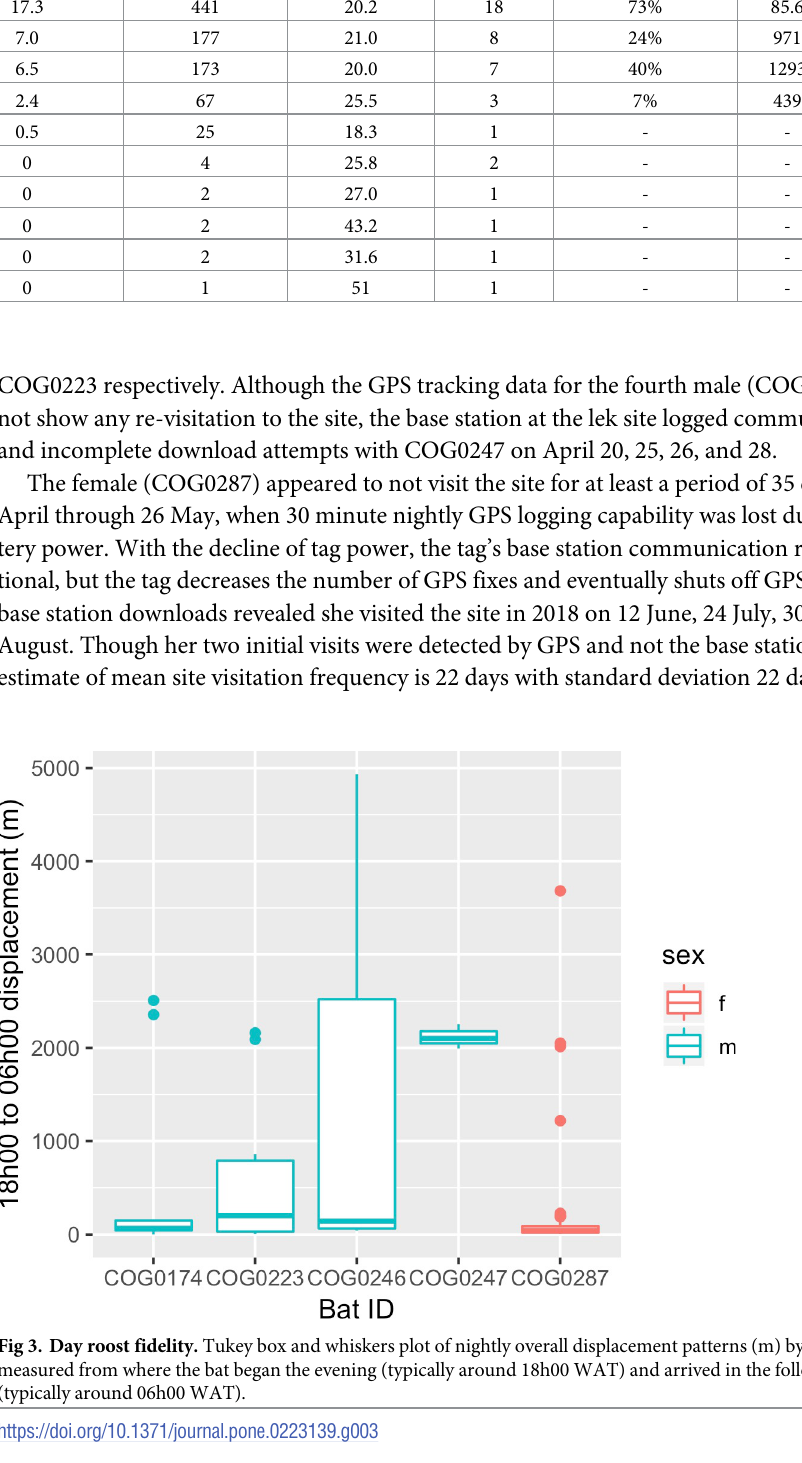
Table 1. Deployment summary for all tagged bats during the April 2018 study period. The table is sorted by the number of GPS locations and additional statistics are shown for the five bats with over 24 hours of GPS data.